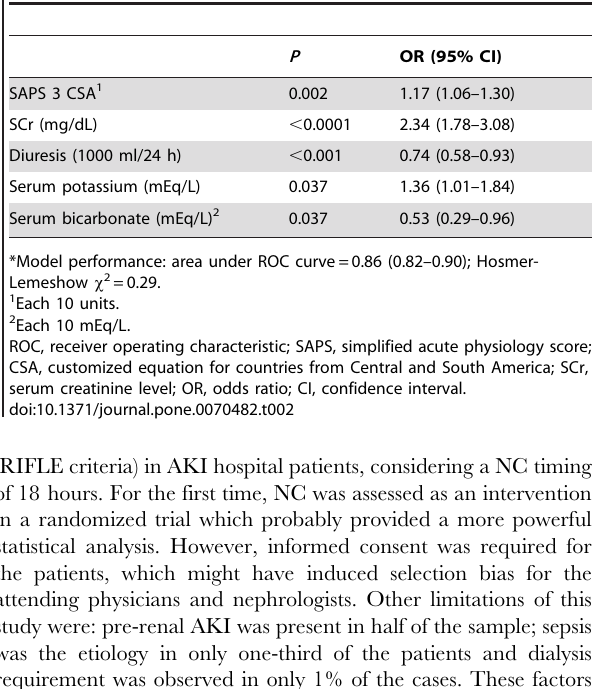
Table 2. Variables retained in the propensity score model for nephrology consultation ( P , 0.05)*.